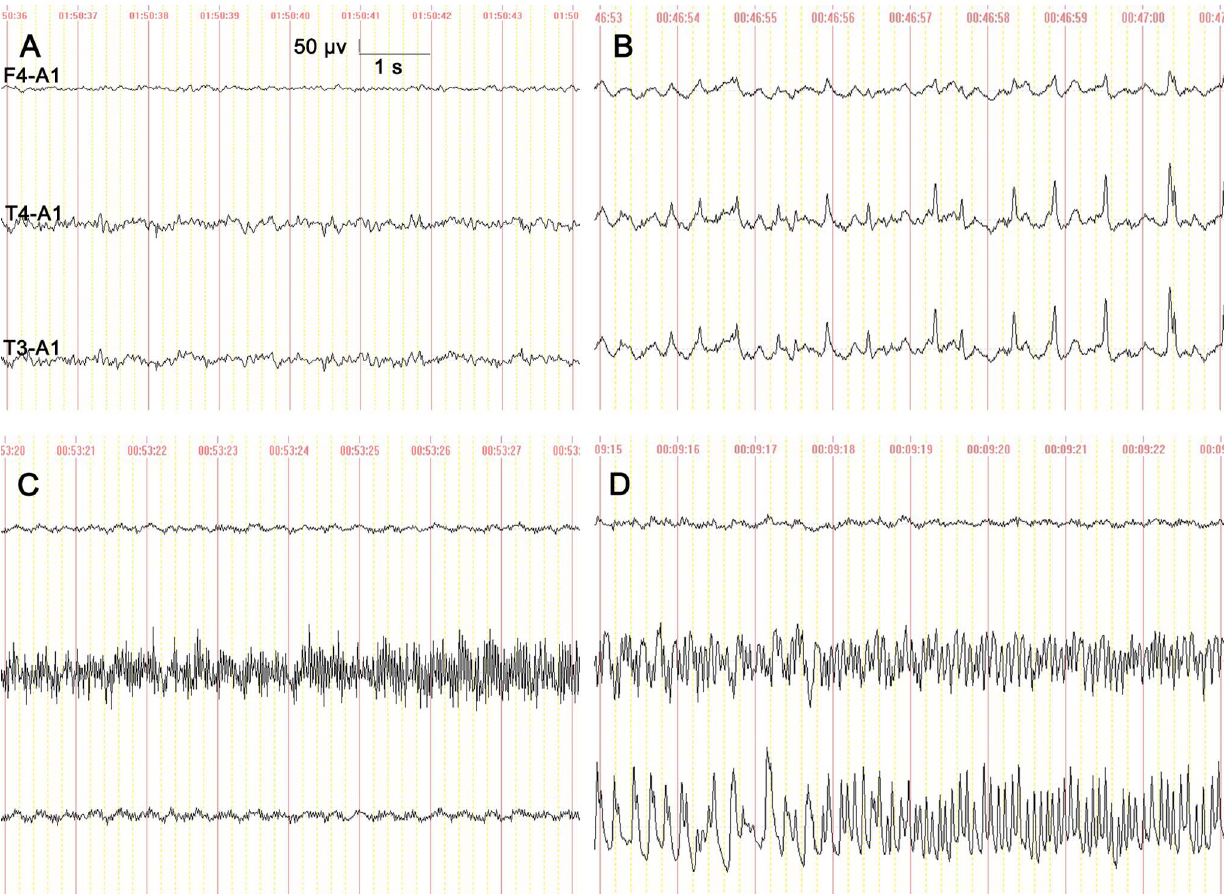
Figure 3. Characterization of electrographic seizure EEG patterns of rats. (A) Normal electrical activity before drug injection; (B) Sporadic interictal sharp wave observed at 4 min after drug injection; (C) Focal EEG seizure with ictal epileptic discharge limited on T4 electrode; and (D) Spreading EEG seizure with ictal epileptic discharge on T4, and T3 or F4 electrode.